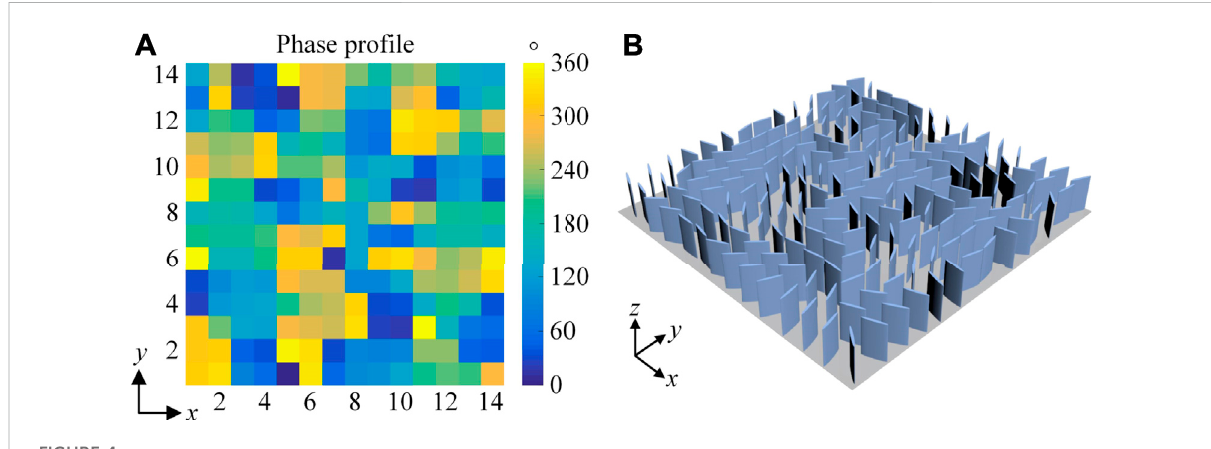
FIGURE 4 (A) The phase pro fi le (B) The structure